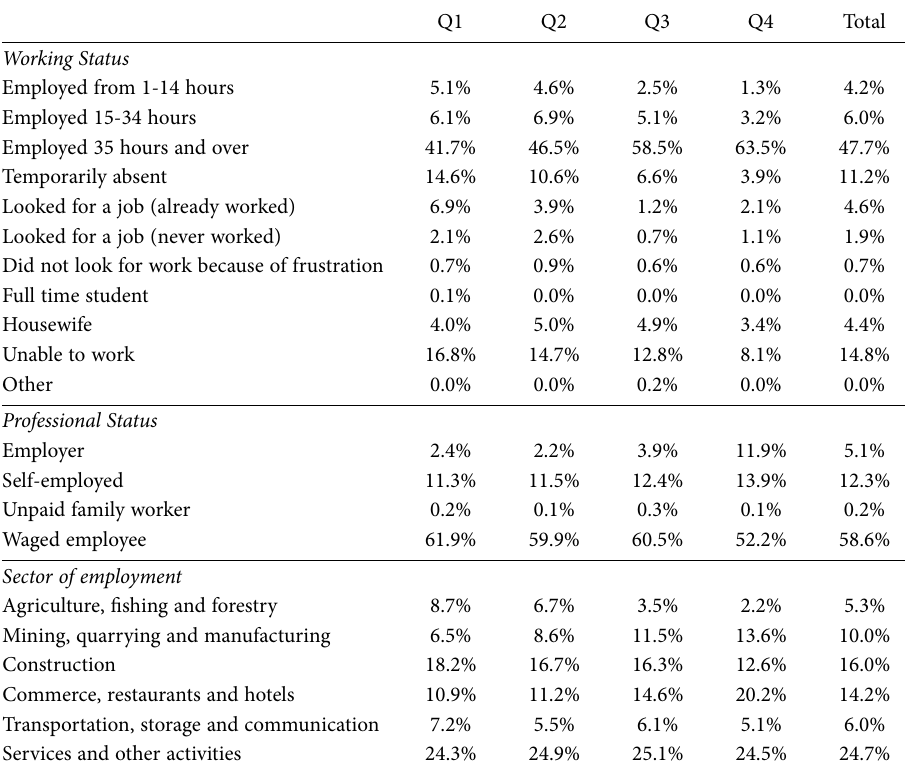
Table 6. Head of household employment statistics per poverty quartile,